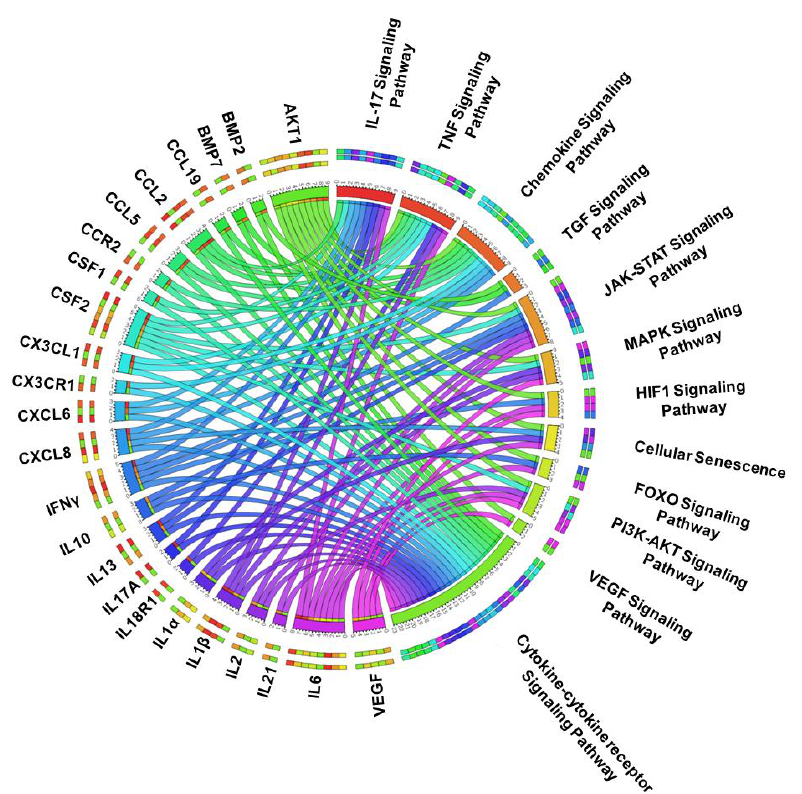
Figure 2. KEGG pathway enrichment analysis identifies the enrichment of inflammatory cytokine and IL17 signaling in IDD: The Circos plot represents significantly enriched pathways associated with regulated genes in the IDD detected using our functional enrichment analysis. The hallmark genes and associated pathways are color coded and were represented using a specific color in the inner ring. The ribbon / arc that originates from di ff erent genes and terminates at associated KEGG pathways demonstrates the connectivity of genes and KEGG pathways. However, the outer ring is composed of multiple color bars (color belonging to the inner ring represents specific genes and KEGG pathways) and represents di ff erent genes enriched in a specific pathway or di ff erent KEGG pathways shared by a single gene. The distinction between genes and pathways shown in circular layout were shown by the space between the two outer rings. When there is a space between the two outer rings, it demonstrates the representation of genes, whereas when both outer rings are connected, it represents the enriched KEGG pathway.